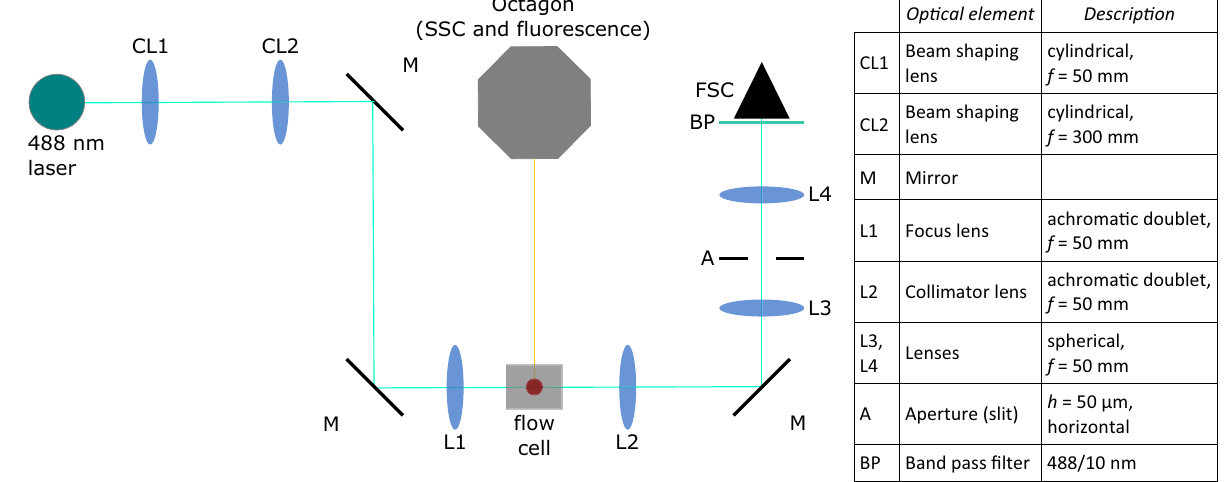
Fig. 5 Schematic drawing of the setup of the modi fi ed LSR II. The beam shaping optics were replaced with a telescope with cylindrical lenses (CL1, CL2) and a new focus lens (L1). The fl ow cell and side scatter (SSC)/ fl uorescence detection channel optics were kept from the original setup (Octagon). For the FSC channel, a collimating lens (L2) is followed by a spatial fi lter in an arrangement similar to a confocal microscope (L3, A, L4). FSC forward scatter, SSC side scatter.